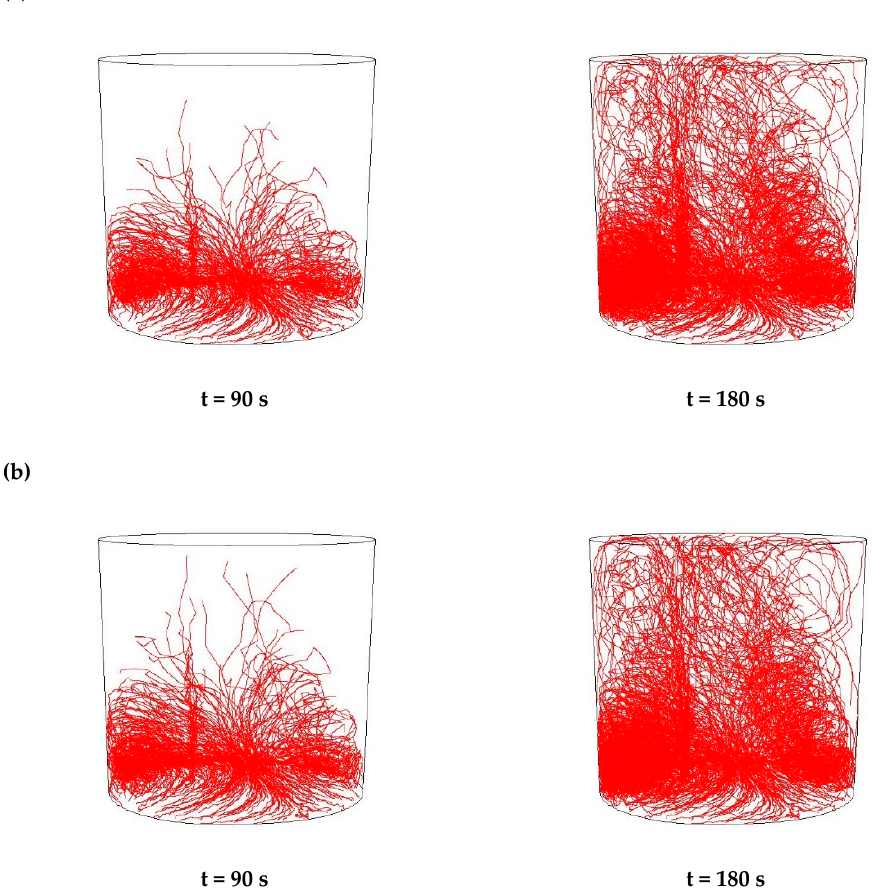
Figure 7. Trajectories of non-metallic Al 2 O 3 inclusions for the case of argon flow of 25 L/min for the particle diameters of ( a ) 18 µm and ( b ) 27 µm in the 18CrNiMo7-6 steel.